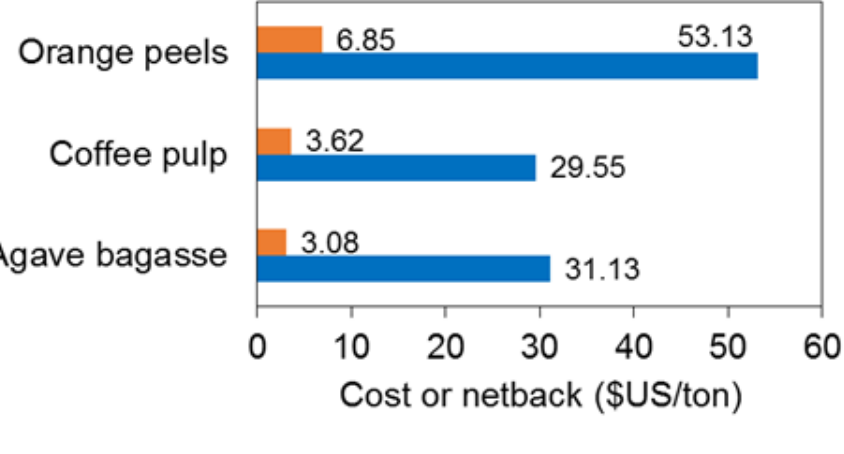
Figure 4. Biomass production cost vs biomass netback for orange peels, coffee pulp and agave